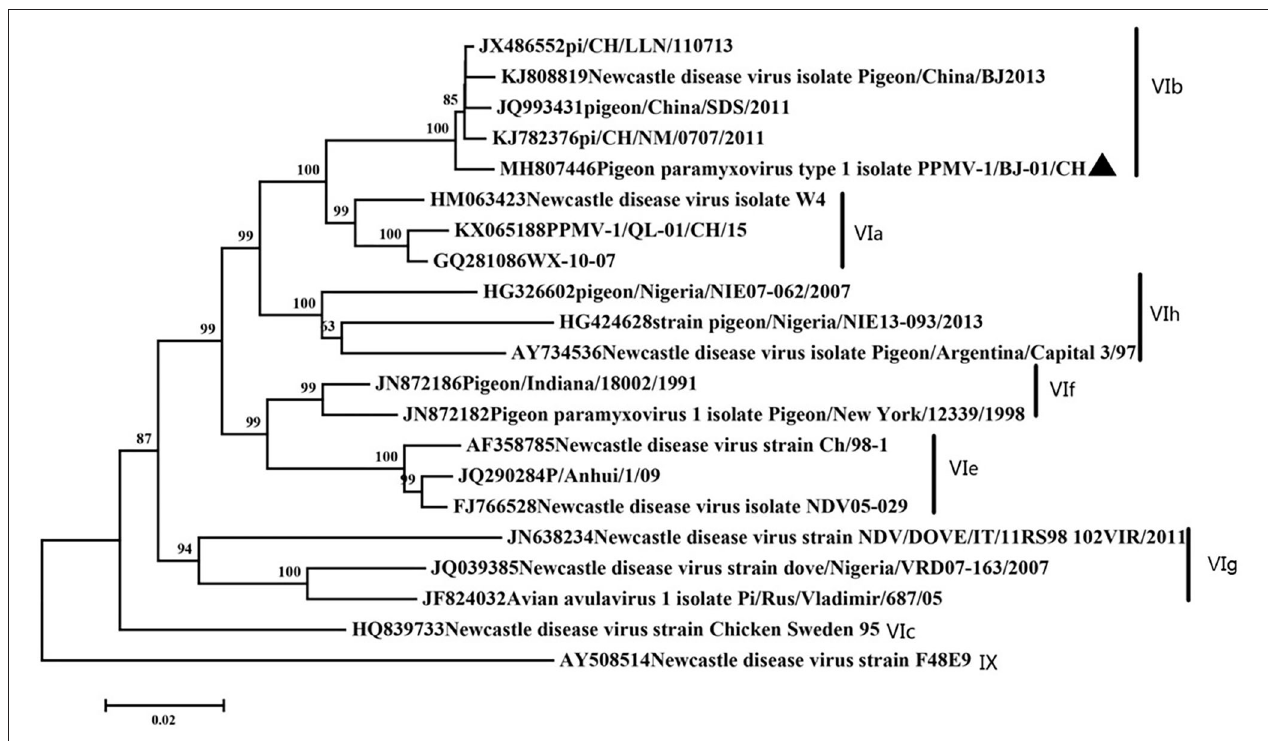
FIGURE 1 | Classification of the virus based on genotype criteria. A maximum likelihood tree of the complete F gene nucleotide sequence. The evolutionary analyses were conducted using the Kimura two-parameter method with 1,000 bootstrap replicates in MEGA7.0. Our isolate was marked with a black triangle.